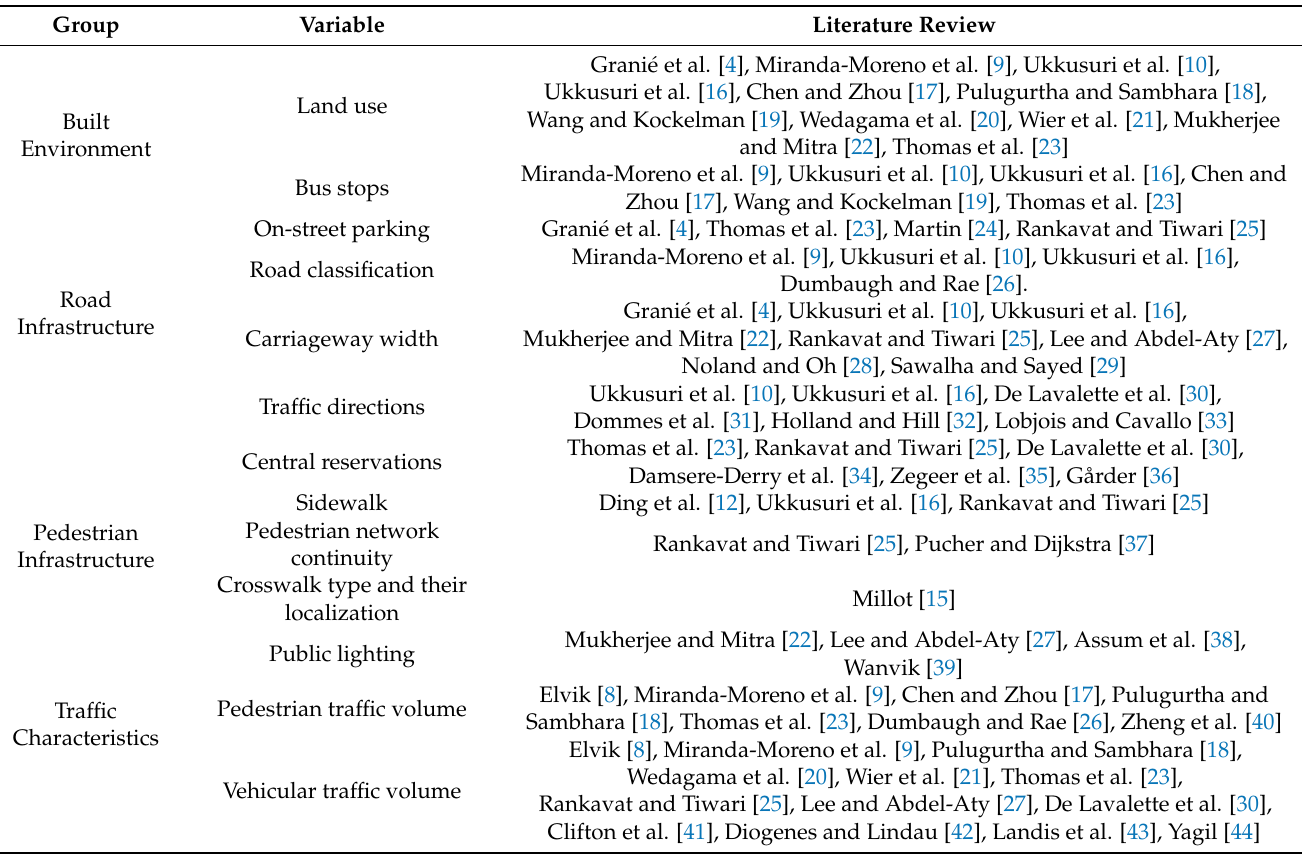
Table 1. Variables addressed in pedestrian safety